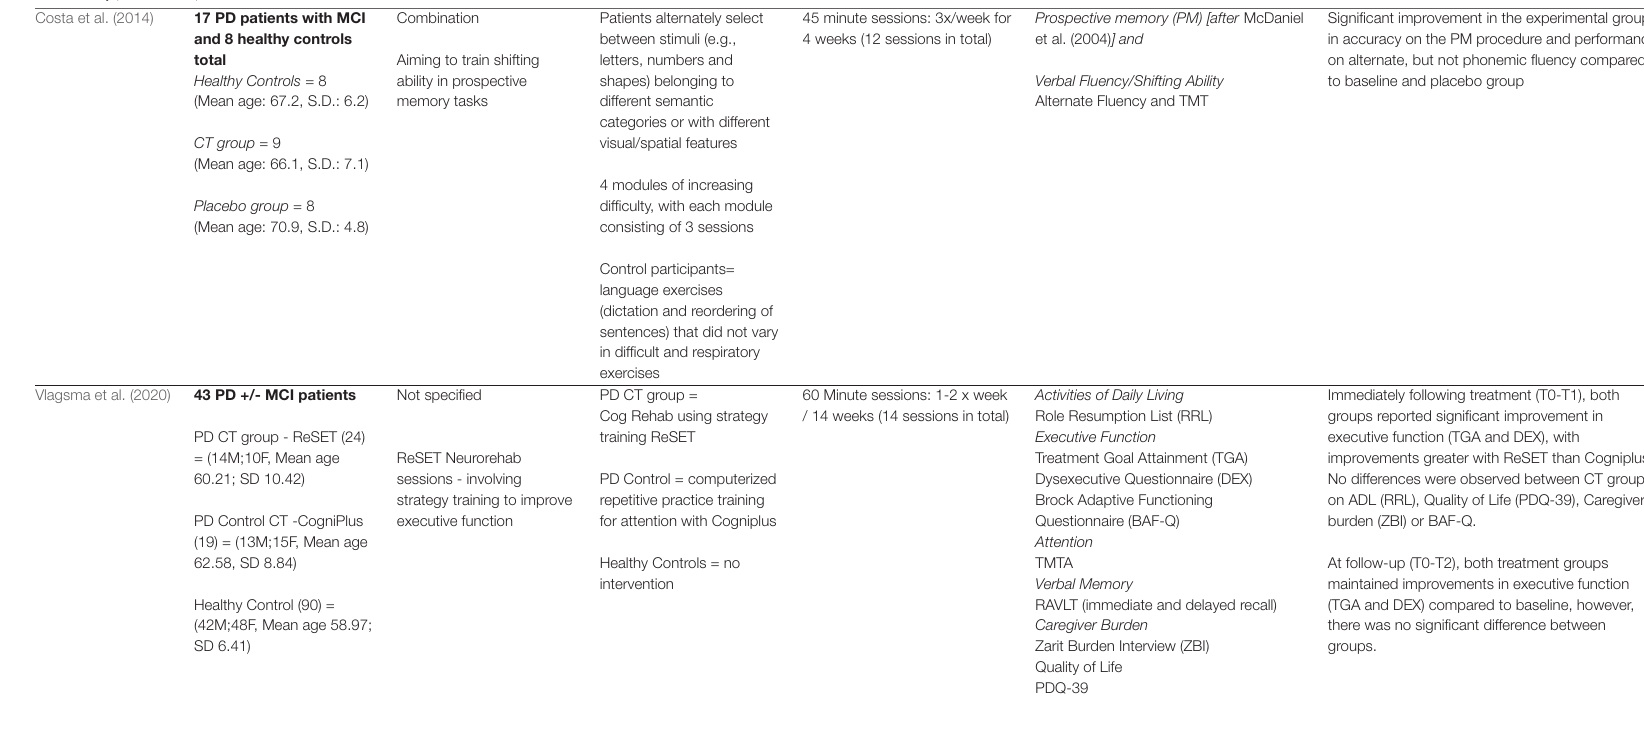
Significant improvement in the experimental group in accuracy on the PM procedure and performance on alternate, but not phonemic fluency compared to baseline and placebo group